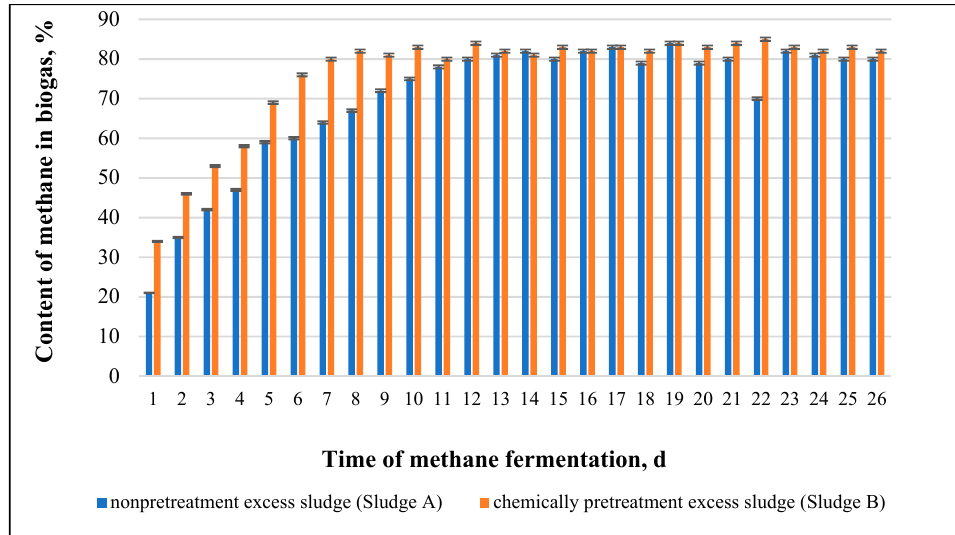
Figure 12. Percentage of methane in biogas expressed as volume percentage recorded during conventional methane fermentation of sludge and methane fermentation of chemically pretreated sludge with the reagent dose of 3.0 mL STERIDIAL W-10/L.